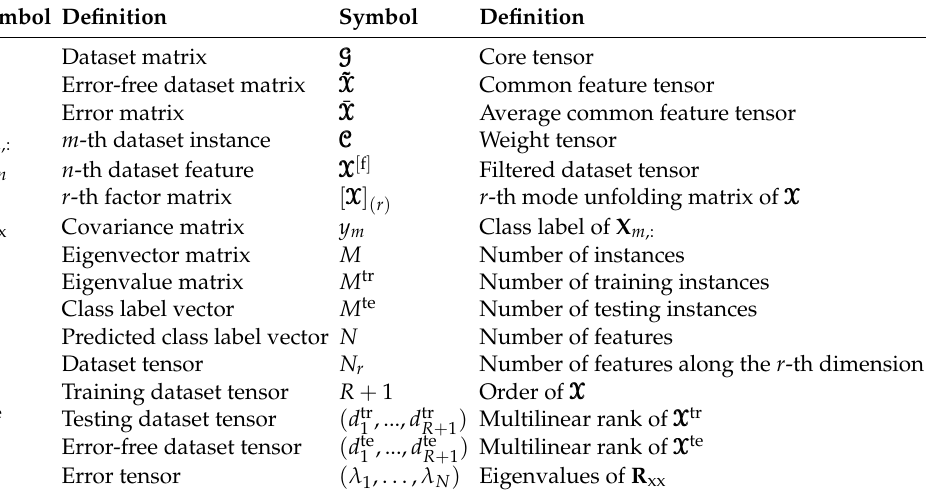
Table 2. Mathematical symbols along this